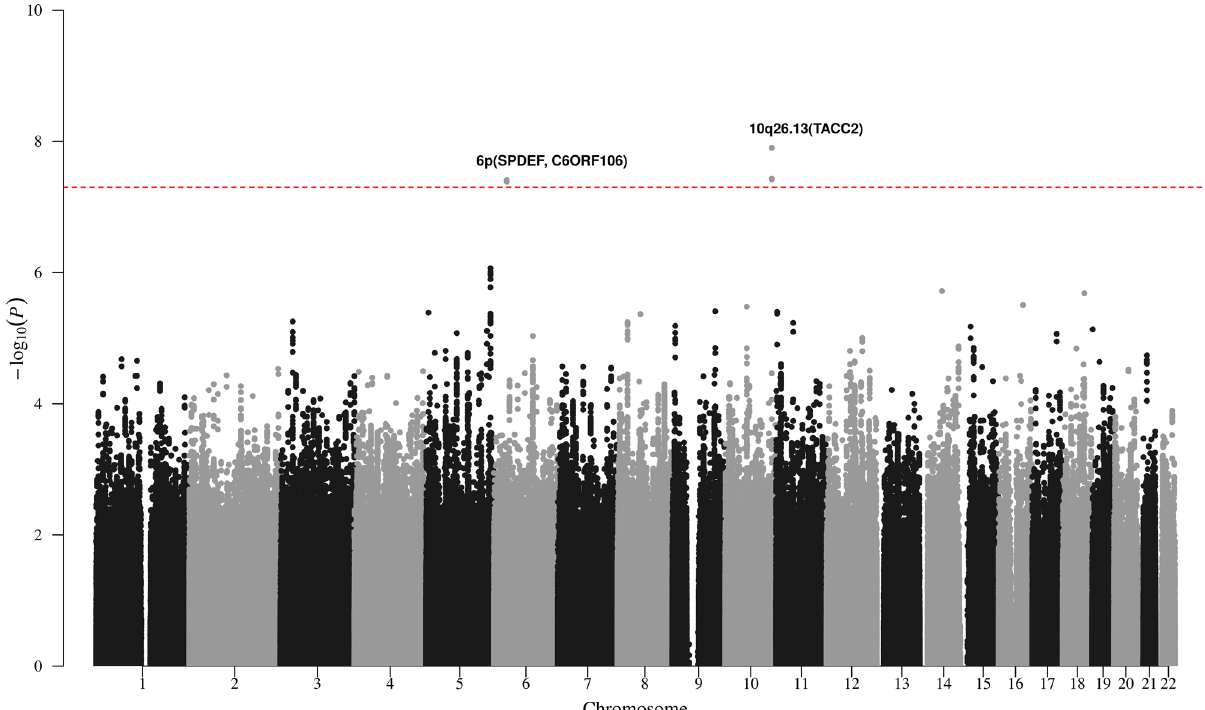
Fig. 1 Manhattan plot from chronic lymphocytic leukemia meta-analysis of 6 genome-wide association studies for variants associating with progressive disease. Manhattan plot of fi xed-effects meta-analysis results for time to fi rst treatment (TTFT). Study-speci fi c single nucleotide polymorphism (SNP) effect sizes were combined using the inverse-variance-weighted approach, and nominal meta P values were calculated based on Z - score statistics. The x -axis represents SNP coordinates on autosomal chromosomes and the y -axis shows the fi xed-effects meta P values in the − log 10 scale. All statistical tests were two-sided and red dashed line indicates signi fi cance at genome-wide level ( P ≤ 5 × 10 − 8 ). Risk loci for progressive CLL are annotated with chromosome position and local